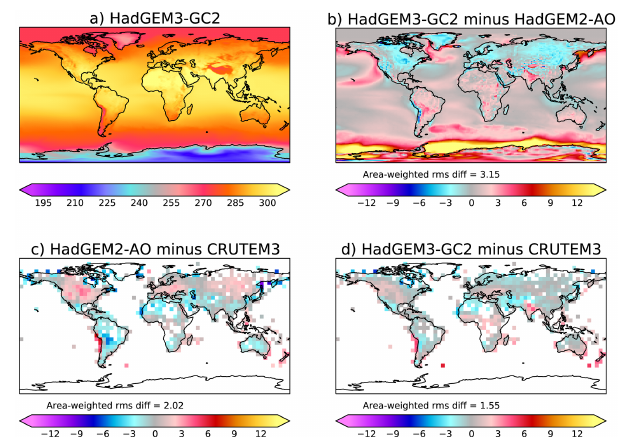
Figure 6. (a) JJA 1.5m temperature (K) from the HadGEM3- GC2 CLIM experiment, (b) HadGEM3-GC2 minus HadGEM2- AO, (c) HadGEM2-AO minus CRUTEM3 observations (Brohan et al., 2006), (d) HadGEM3-GC2 minus CRUTEM3 observations.